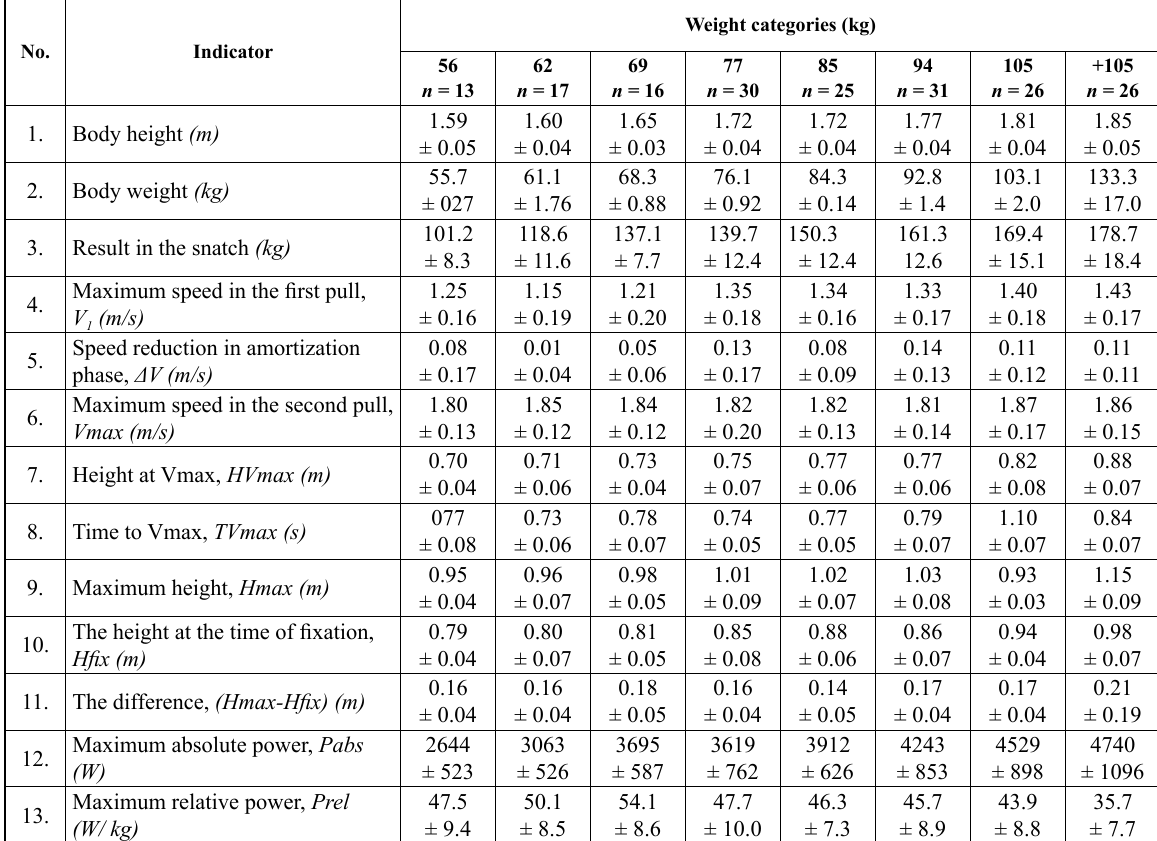
Table 1. Mean values and standard deviations of the parameters of motion of the bar in the snatch in athletes of different weight categories